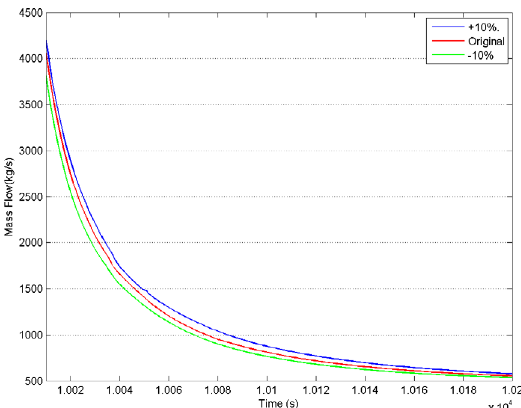
Fig. 14. HFA cladding temperature (1D).